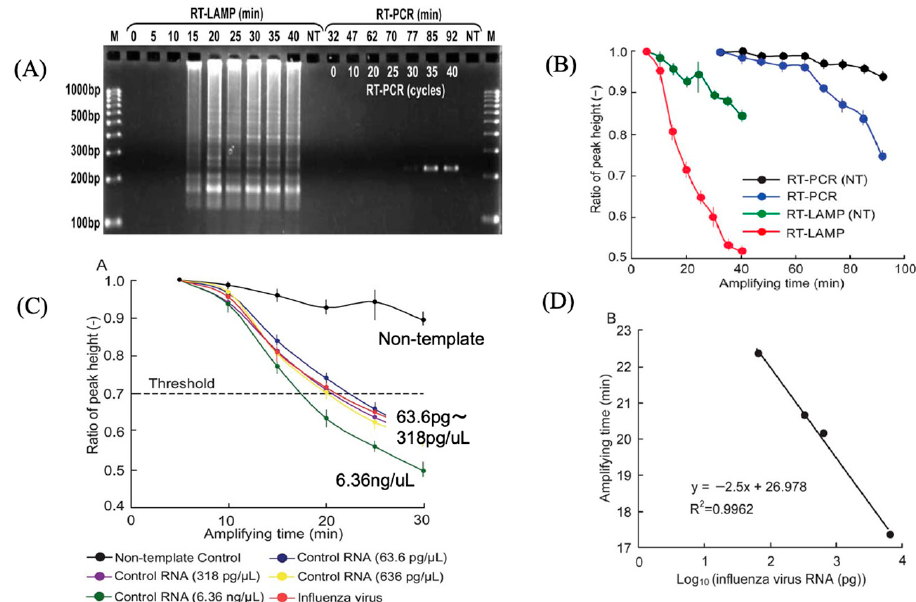
Figure 17. Influenza virus measurement using isothermal gene amplification [20]. ( A ) Electrophoresis of RT-LAMP and RT-PCR-amplified genes encoding Influenza virus ( B ) Comparison of electrochemical responses of RT-LAMP and RT-PCR ( C ) Electrochemical responses with different copies of RNA and influenza sample ( D ) Calibration of influenza RNA.